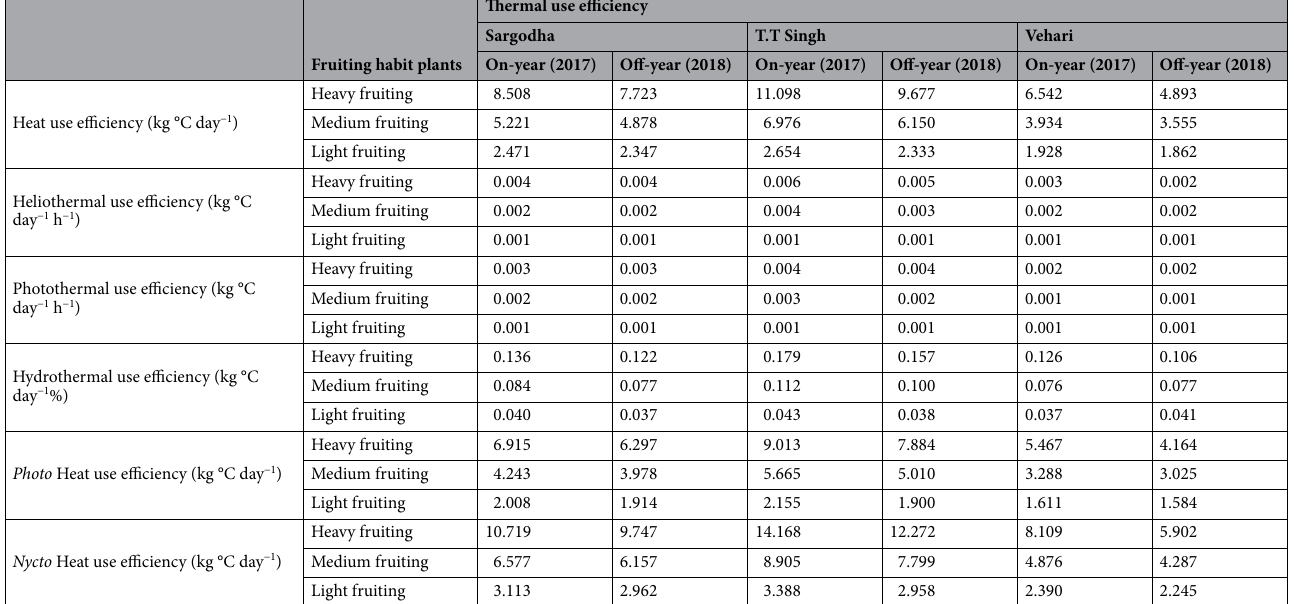
Table 3. Thermal use efficiency of Kinnow plant in biennial bearing pattern.